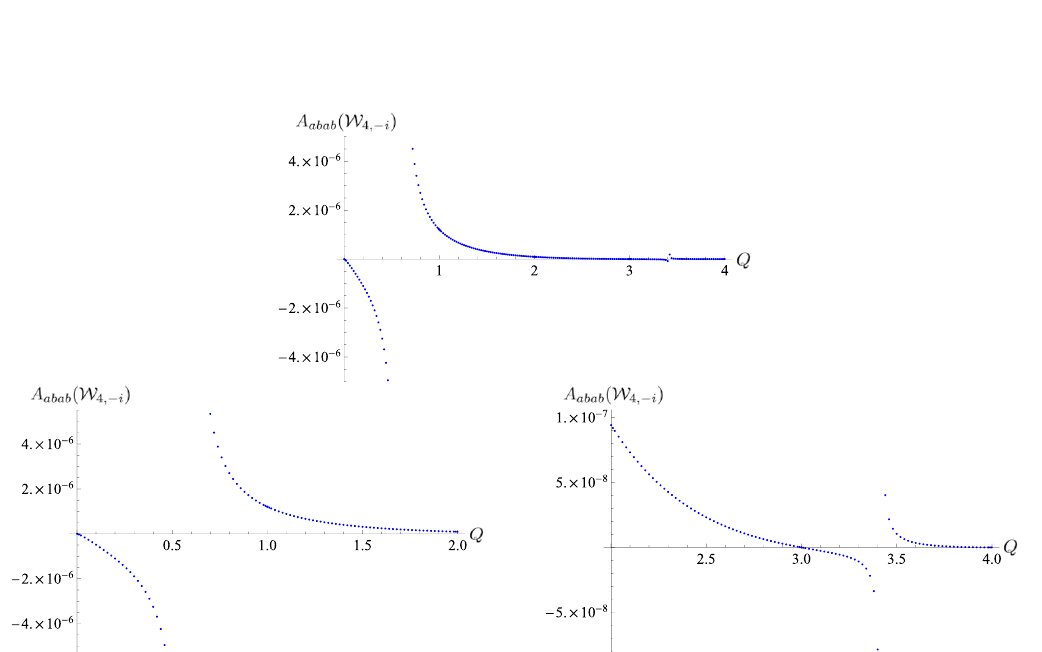
Figure 13 . The bootstrap result of the amplitude A abab ( W 4 , − i ) and its detailed pole structures in the regions 0 < Q < 2 and 2 < Q < 4